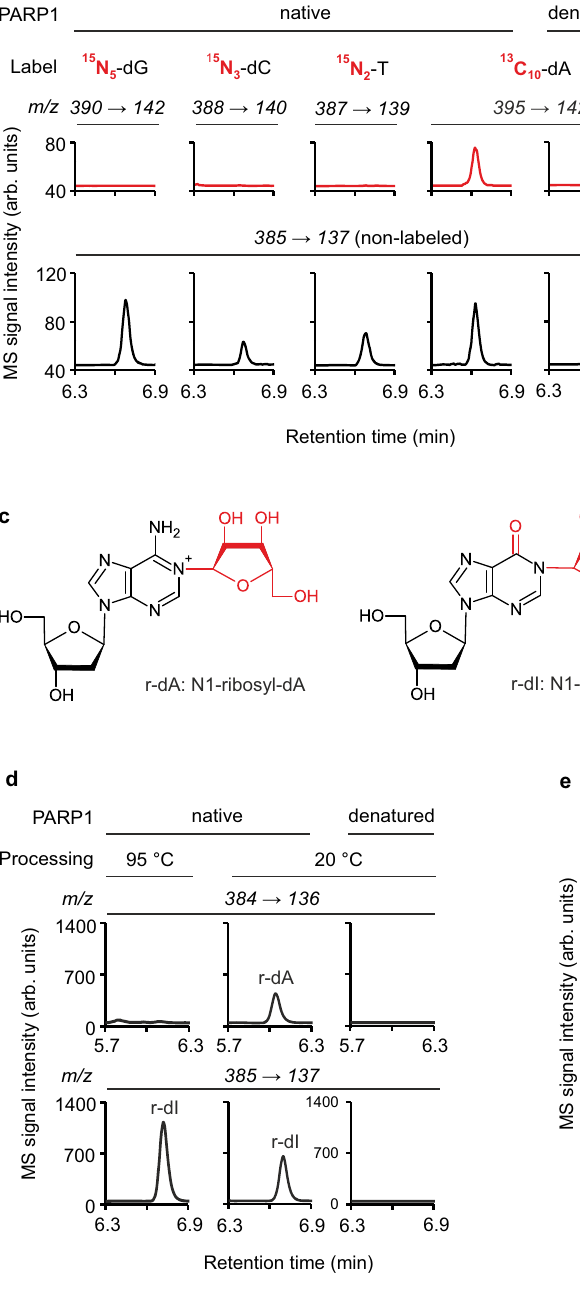
to bottom). c Spontaneous deamination of N1-ribosyl dA (r-dA, attached ribose moietyinred)leadstoN1-ribosyl-dI(r-dI,ribosemoietyandO 6 inred). d LC-MS/MS chromatograms of reaction products from in vitro PARylation assays as in a but with substrate #3 in which reaction products were either processed at 95°C or 20°C before mass spec analysis, and screened for signals with m/z transitions expected for N1-ribosyl-dA (r-dA, m/z 384 → 136, top) or N1-ribosyl-dI (r-dI, m/z 385 → 137, bottom). e LC-MS/MS chromatograms of N1-ribosyl-dI, (arrows, m/z 385 → 137) enriched from 5mg pig liver and 2.5mg mouse kidney DNA and com- pared to the reaction product of an in vitro PARylation assay with PARP1 on substrate